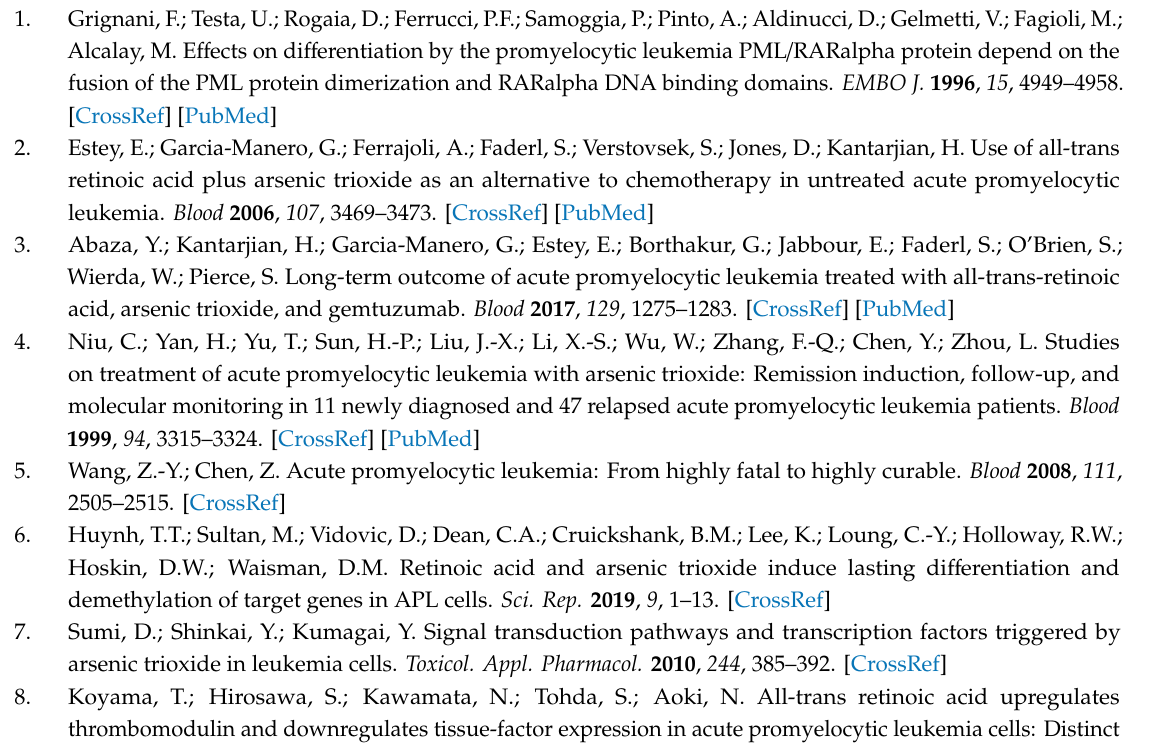
Table S1: Protein content of supernatant of NB4 cell lines, Table S2: Protein content of supernatant of NB4 cell lines, Table S3: List of chemicals and reagents were used, Figure S1: Representative images of May-Grünwald-Giemsa staining, Figure S2: Production of ROS in vehicle treated NB4 cells, Figure S3: mRNA expression of MCP-1, IL-1 β and TNF α inflammatory biomarkers, Figure S4: The protein content of the supernatants of NB4 cell lines was quantified by